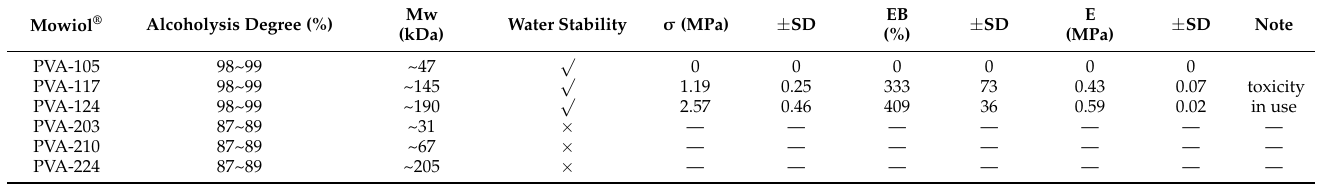
Table 1. Effect of the PVA type on the formation of UND-based PVAHMs and their properties. Mw Mowiol ® Alcoholysis Degree (%) (kDa) Water